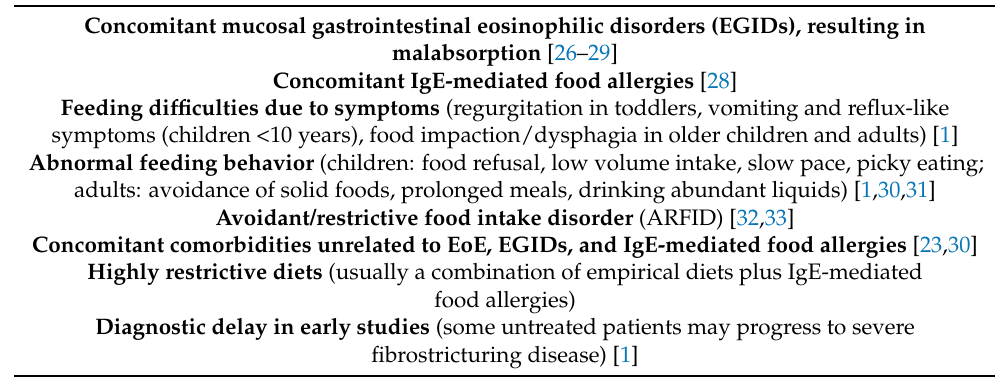
Table 2. Potential reasons leading to failure to thrive/malnutrition in EoE